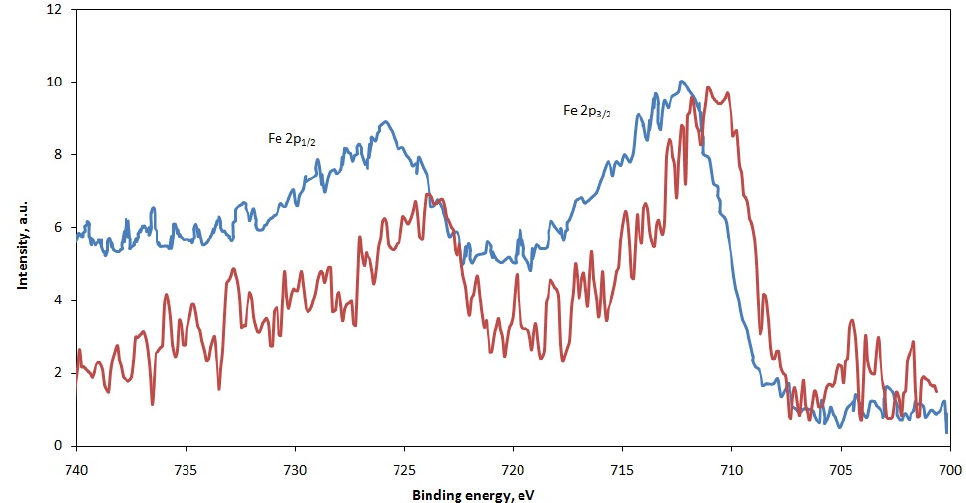
Figure 5. XPS Fe2p spectra from the surface of slag #3 (red) and ash (blue) samples.